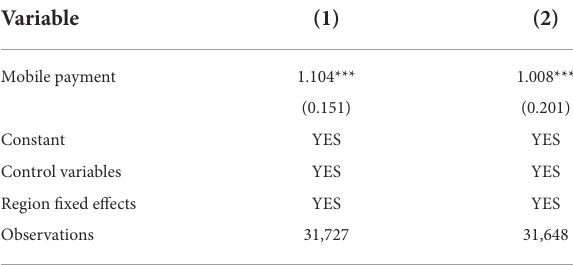
TABLE 8 Mechanism test 1: the impact of mobile payment on private health insurance. Variable